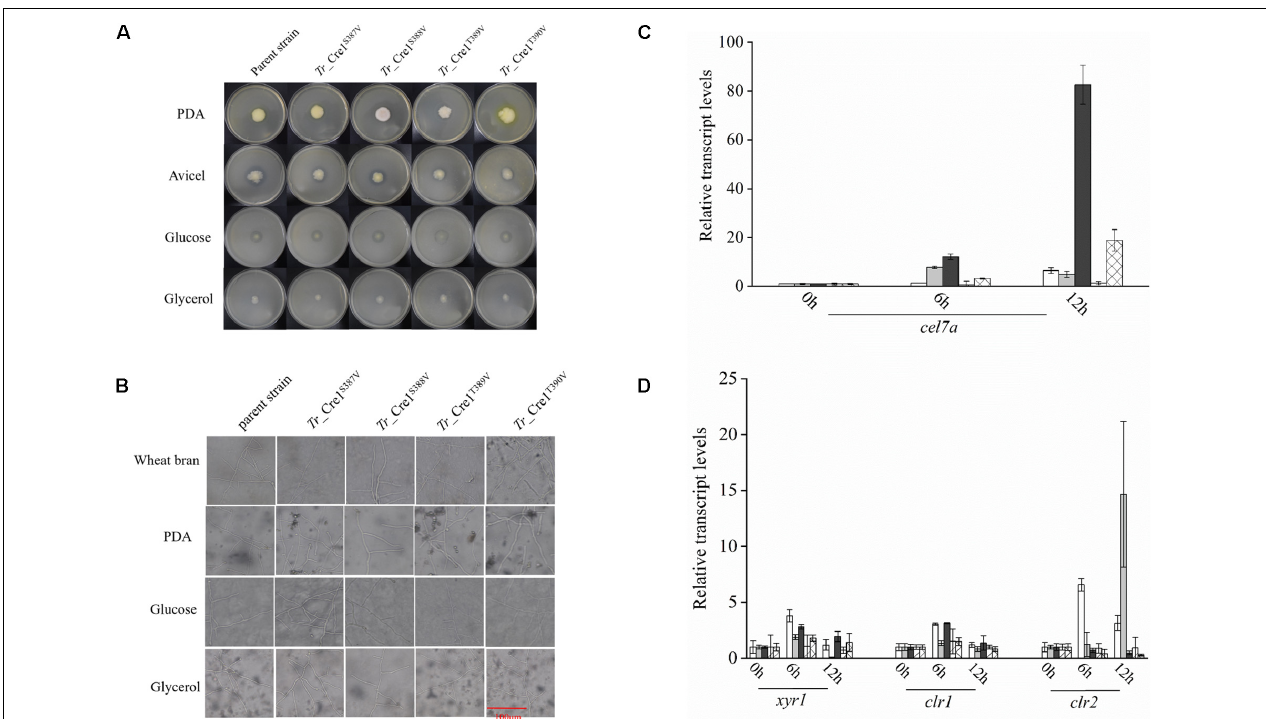
FIGURE 2 | Analysis of phenotypic characterization and transcriptional levels. (A) Morphologies of the parent strain and transformants on plates containing different carbon sources. For growth assays, transformants and parent strain were grown on plates with 2% (w/v) potato dextrose agar (PDA), avicel, glucose, or glycerol as a sole carbon source. Plates were incubated at 30 ◦ C and pictures were taken after 144 h. (B) Microscopic observation of hyphae of parent strain and transformants. Approximately, 1 × 10 3 spores were inoculated on slides with solidified medium containing PDA, wheat bran, MM with 2% glucose, or MM with 2% glycerol at 30 ◦ C for 48 h. Scar bar: 100 µ m. (C) Transcriptional levels of cel7a in the parent strain and transformants. Transcriptional levels of cel7a in Tr_ Cre1 S387V (gray), Tr _ Cre1 S388V (dark), Tr _ Cre1 S389V (oblique line), Tr _ Cre1 S390V (gridlines) transformants and parent strain (blank) grown in presence of a mixture of glucose and avicel as carbon source. Gene expression levels were normalized (2 − (cid:49)(cid:49) CT analysis) to that of actin . Mean values are shown; error bars indicate the standard deviation of three independently grown cultures. (D) Transcriptional levels of xyr1 , clr1 , and clr2 in the parent strain and transformants. Transcriptional levels of xyr1 , clr1 , and clr2 in Tr_ Cre1 S387V (gray), Tr _ Cre1 S388V (dark), Tr _ Cre1 S389V (oblique line), Tr _ Cre1 S390V (gridlines) transformants and parent strain (blank) grown in presence of a mixture of glucose and avicel as carbon source. Gene expression levels were normalized (2 − (cid:49)(cid:49) CT analysis) to that of actin . Mean values are shown; error bars indicate the standard deviation of three independently grown